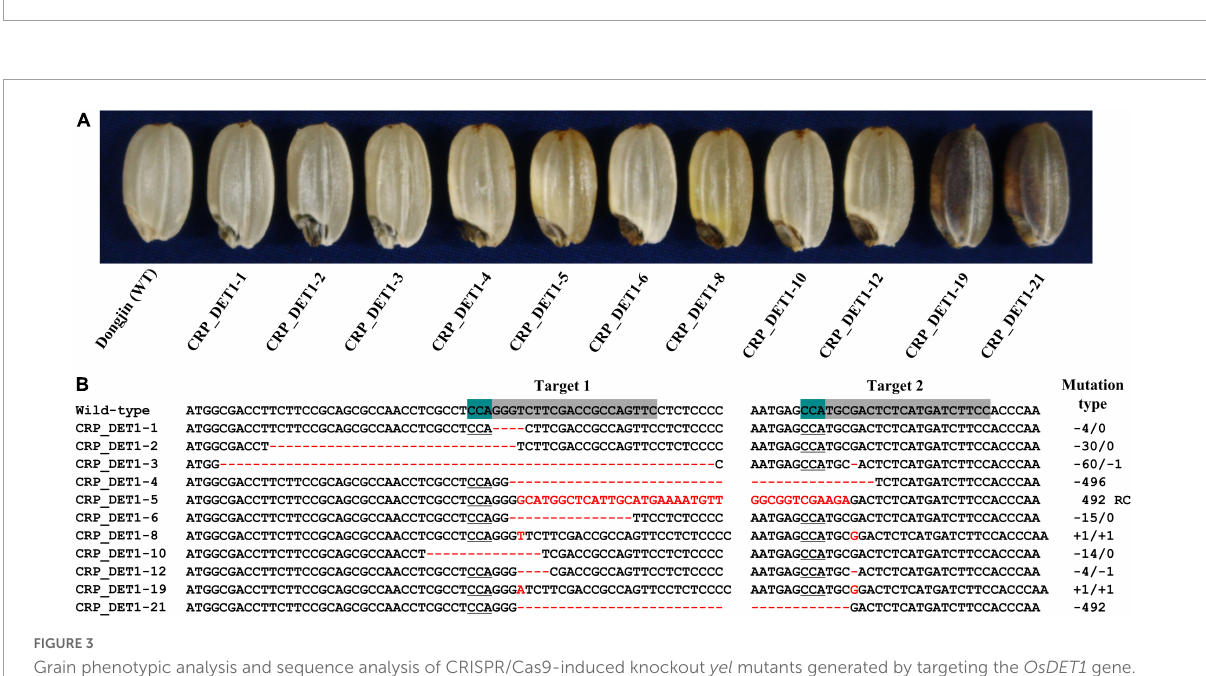
FIGURE3 Grain phenotypic analysis and sequence analysis of CRISPR/Cas9-induced knockout yel mutants generated by targeting the OsDET1 gene. (A) Grain phenotype of Dongjin (WT) and transgenic seeds. Grains showing the yel phenotype were randomly selected from each positive T 0 transgenic plant. (B) Comparison of the OsDET1 nucleotide sequence targeted by CRISPR/Cas9 in WT and mutant plants. Targets 1 and 2 represent the first and second exons, respectively, of OsDET1 ( LOC _ Os01g01484 / Os01g0104600 ). Red dashes and letters indicate deletions and insertions, respectively, in transgenic lines. The protospacer adjacent motif (PAM) is highlighted in green in the WT and is underlined in mutant lines. Sequences of targets 1 and 2 are highlighted in gray in the WT. Mutation types are shown to the right of each mutated sequence (-, deletion; +, insertion; RC, reverse